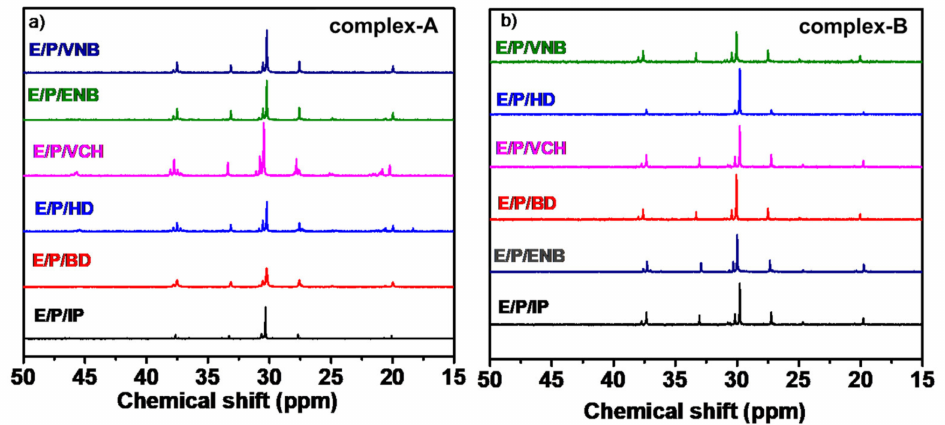
Figure 9. 13 C-NMR spectrum for ethylene/propylene/diene (conjugated and nonconjugated) ter- polymers produce with ( a ) complex A and ( b ) complex